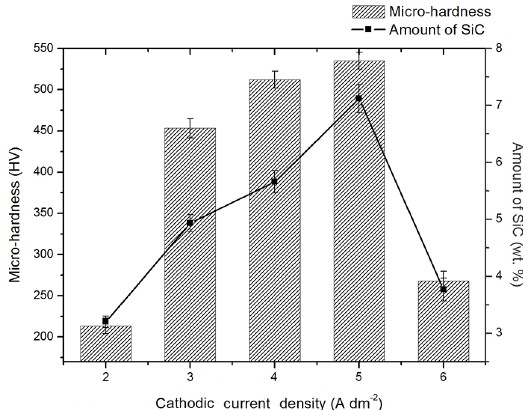
Figure 4. Effect of current cathodic density on micro-hardness and amount of SiC nanoparticles deposited in Co-Ni metal